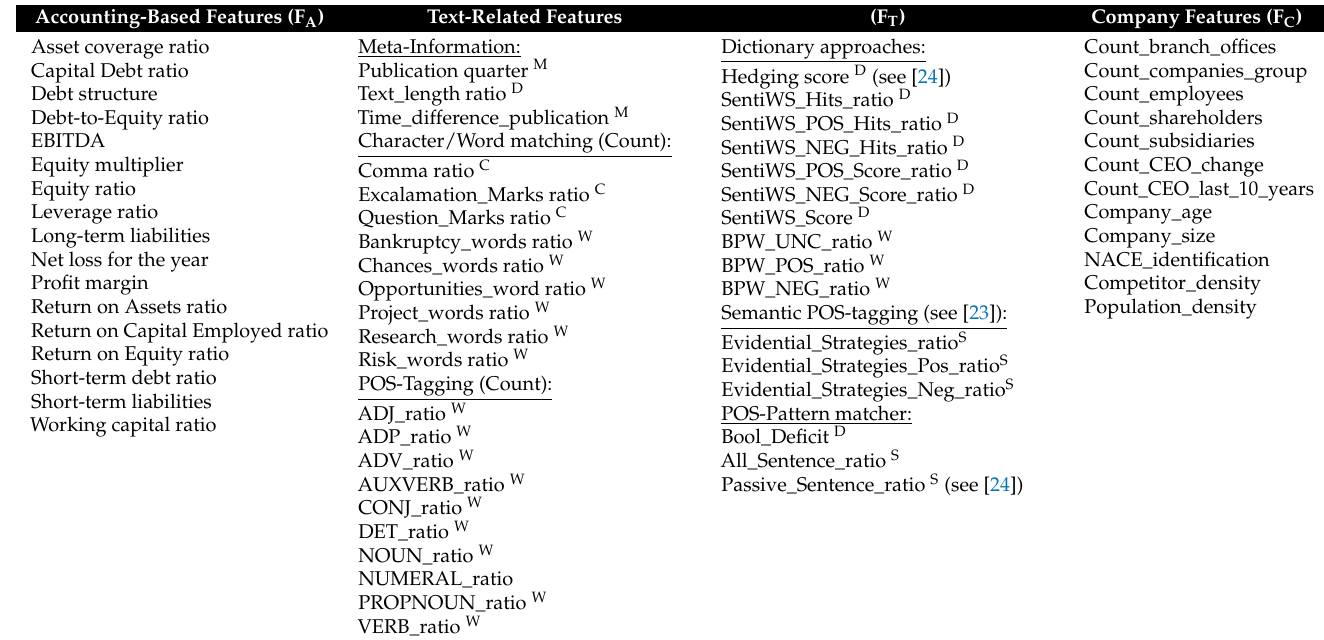
Figure 1. Summary of the methodical procedure and the associated steps. Table 1. Feature sets for XGBoostClassifier model